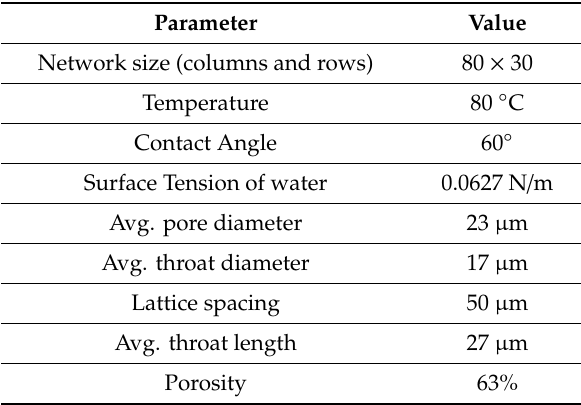
Table 2. Simulation Table 2 . Simulation Parameters.